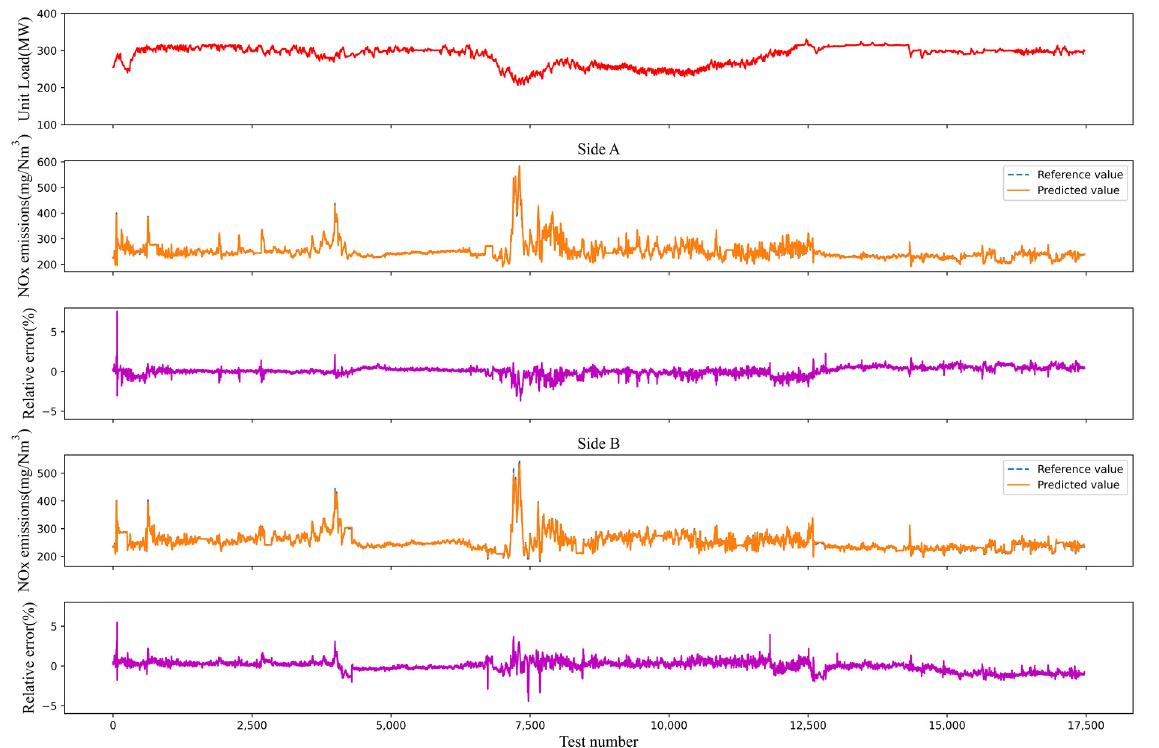
Figure 4. The variations of unit load and detailed predictive results of our model at the test subset for the 13th run.